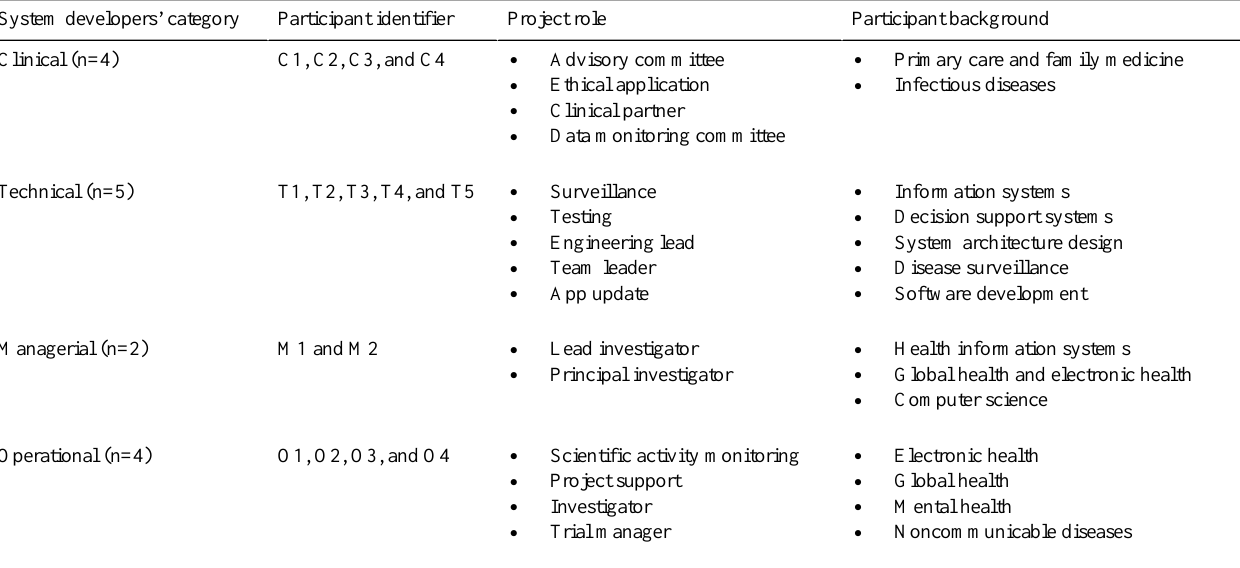
Table 1. System developers’project roles and